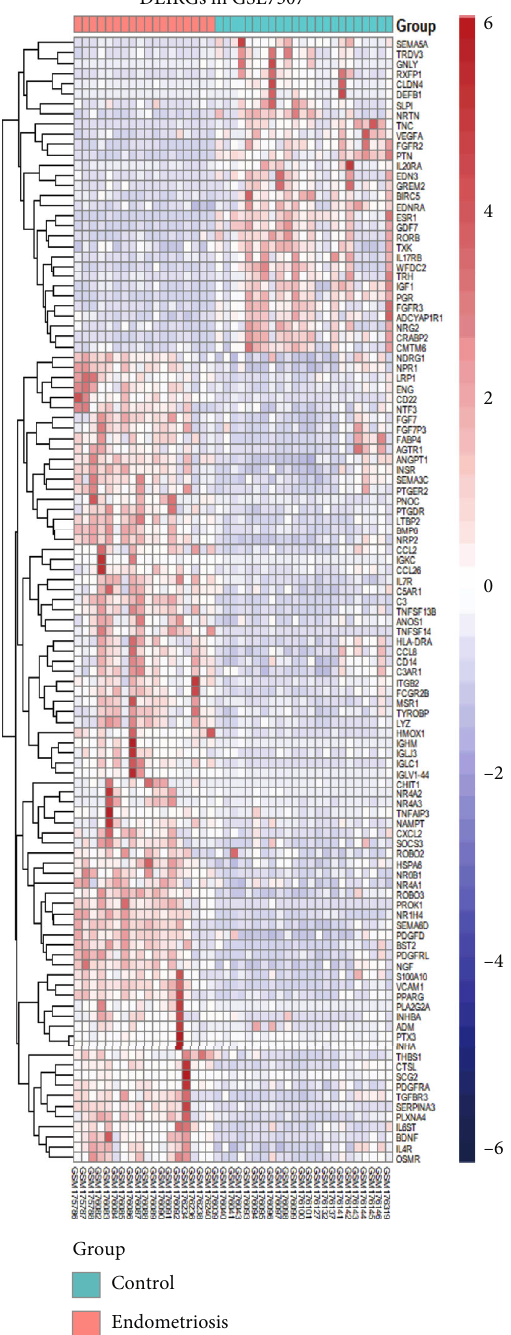
Figure 5: The heatmap of 111 DEIRGs in GSE7305. Each row represents an IRG.